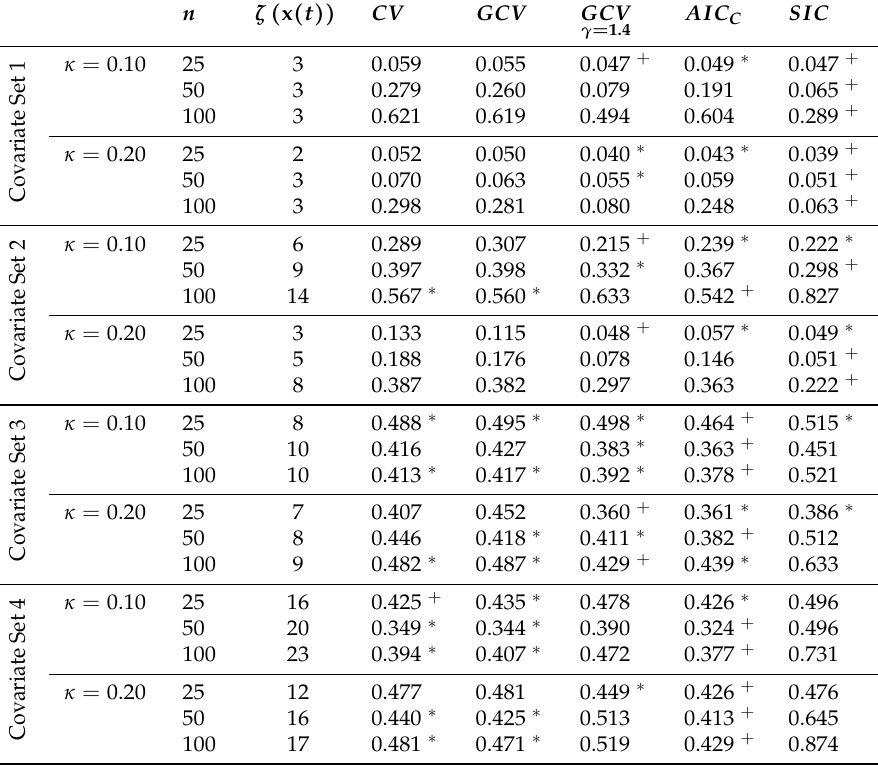
Table 2. Analogous to Table 1 for parameter curve β 2 ( t ) .